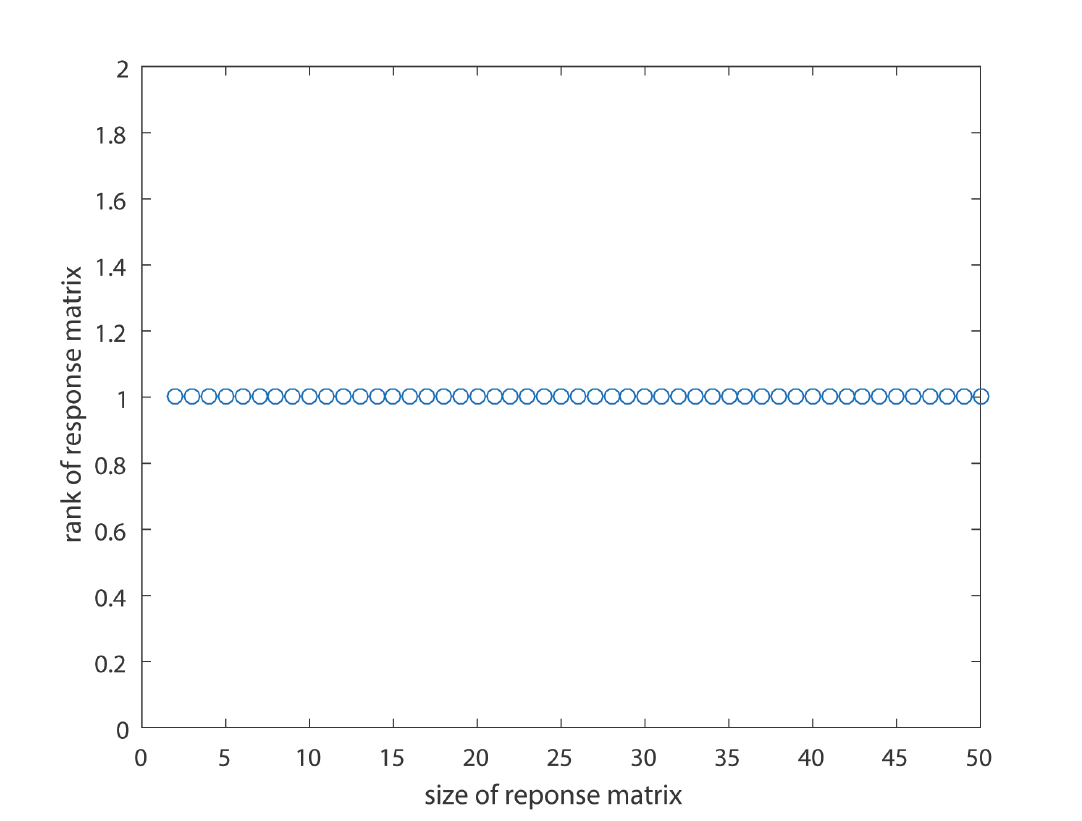
Figure 4. The rank of the responses matrices as a function of the responses matrix dimensions for the case of a first order